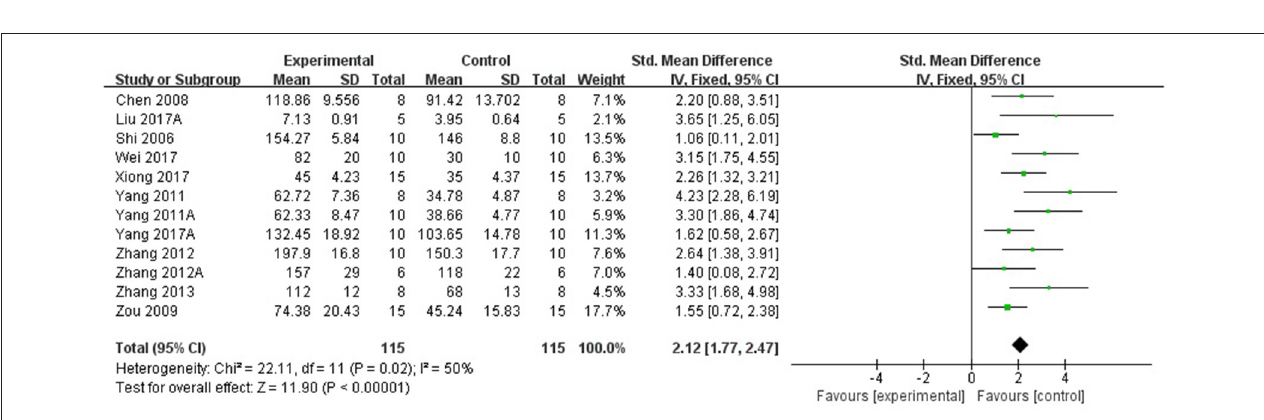
FIGURE 6 | The forest plot: effects of Rhodiola rosea L. for increasing superoxide dismutase compared with control group.